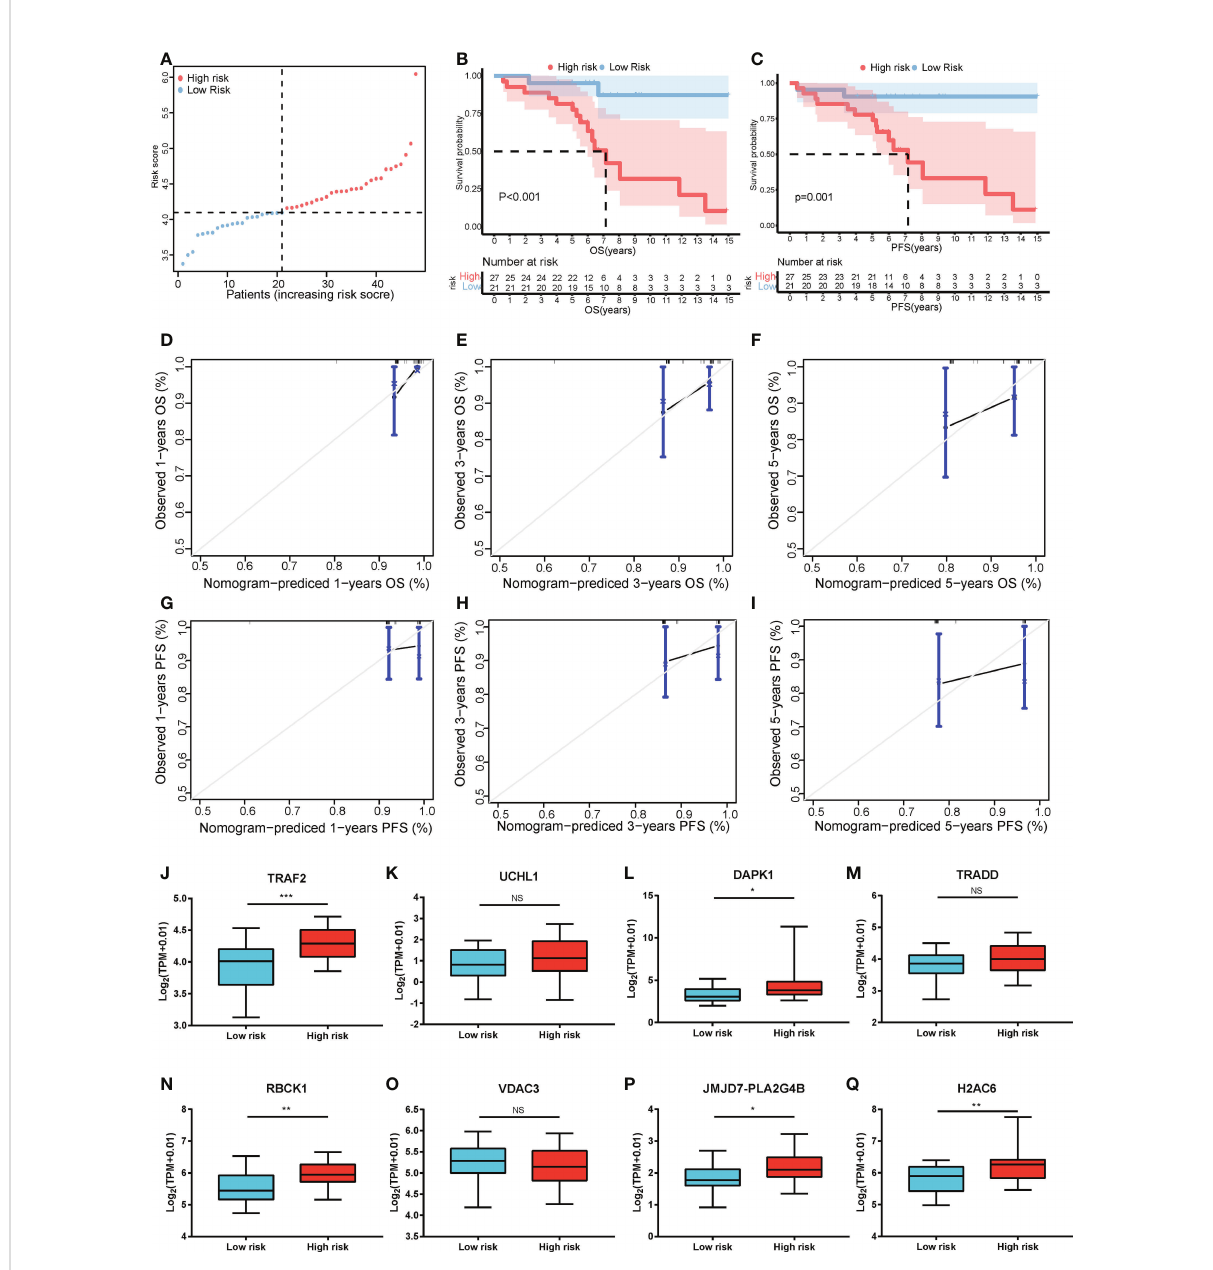
FIGURE 8 Validation of the risk score model. (A) The distribution and cutoff value of the risk scores in the GSE152430 cohort. Kaplan – Meier curves for the OS (B) and PFS (C) of patients in the high- and low-risk groups in the GSE152430 cohort. Calibration graphs indicate that the predicted 1- (D) , 3- (E) , and 5-year (F) OS rates correspond with the actual survival rates. Calibration graphs indicate that the predicted 1- (G) , 3- (H) , and 5-year (I) PFS rates correspond with the actual survival rates. The expression of the eight necroptosis-related genes [ TRAF2 (J) , UCHL1 (K) , DAPK1 (L) , TRADD (M) , RBCK1 (N) , VDAC3 (O) , JMJD7-PLA2G4B (P) , H2AC6 (Q) ] between the low-risk group and the high-risk group in the GSE152430 cohort. * P < 0.05, ** P < 0.01, *** P < 0.001. OS, overall survival; PFS, progression-free survival. NS, no signi fi